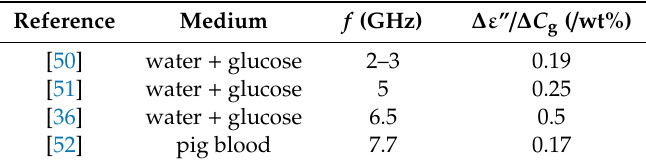
Table 5. Values of ∆ ε ” / ∆ C g obtained from the scientific literature.